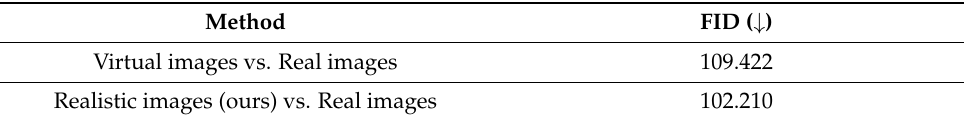
Table 3. Quantitative evaluation result of the proposed